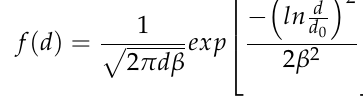
Figure 4. Magnetization versus magnetic field for magnetic fluid, magnetosome chains, and the mixture of magnetic fluid and magnetosomes (ratio 1:1), ( a ) and a zoom resolution where an indi- cation of non-zero coercivity can be observed in the case of magnetosomes ( b ).